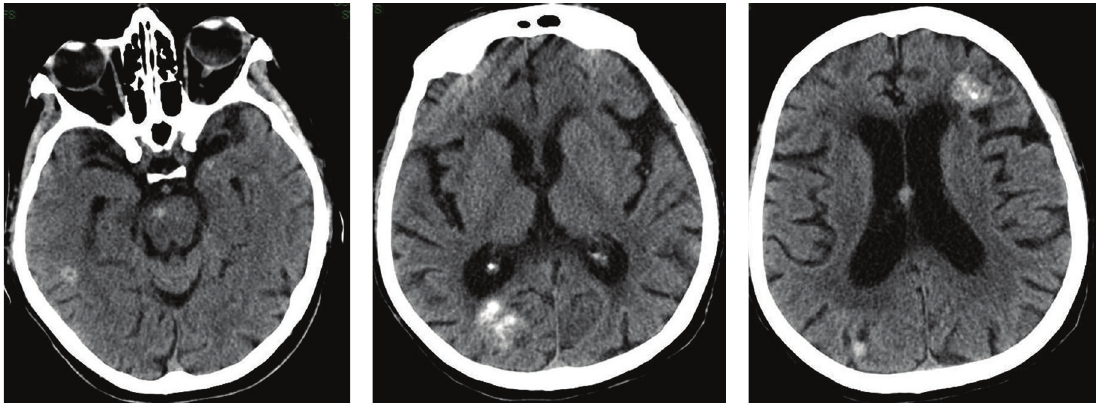
Figure 5: Neurocysticercosis—the nodular calcified stage. In these axial CT scan slices, multiple spontaneous hyperdense lesions are seen, somewith pseudocysticaspects, withcalcifications insideandwithout oedema orenhancement, located at thecortex/subcortical whitematter border, in temporal, parietal, and frontal lobes. One pontine lesion is visible as well. Department of Neurology, Colentina Clinical Hospital brain imaging archive.